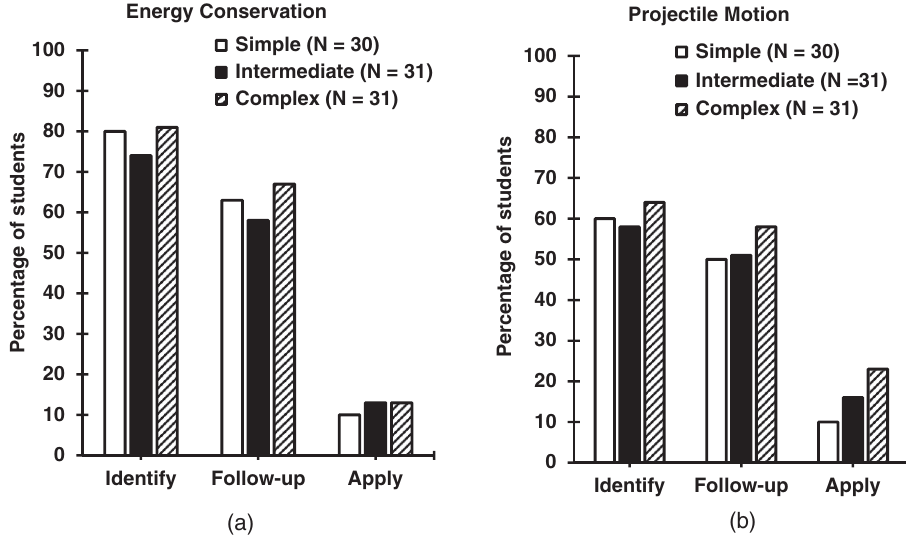
FIG. 4. Conceptual performance across sequential synthesis tasks with varying mathematical complexity for the (a) spring event and (b) trajectory